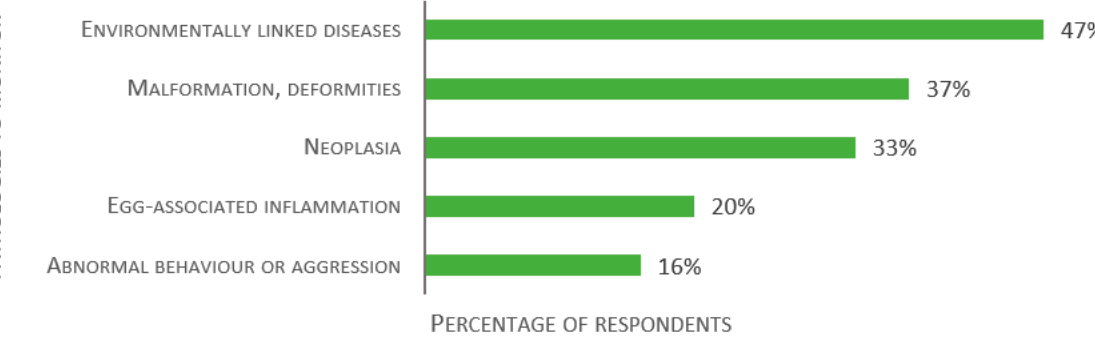
Figure 8. Replies to the open-ended question: “Please list what you consider the main non-infectious diseases to monitor in the laboratory fish”, presented as percentage of respondents ( n = 49).